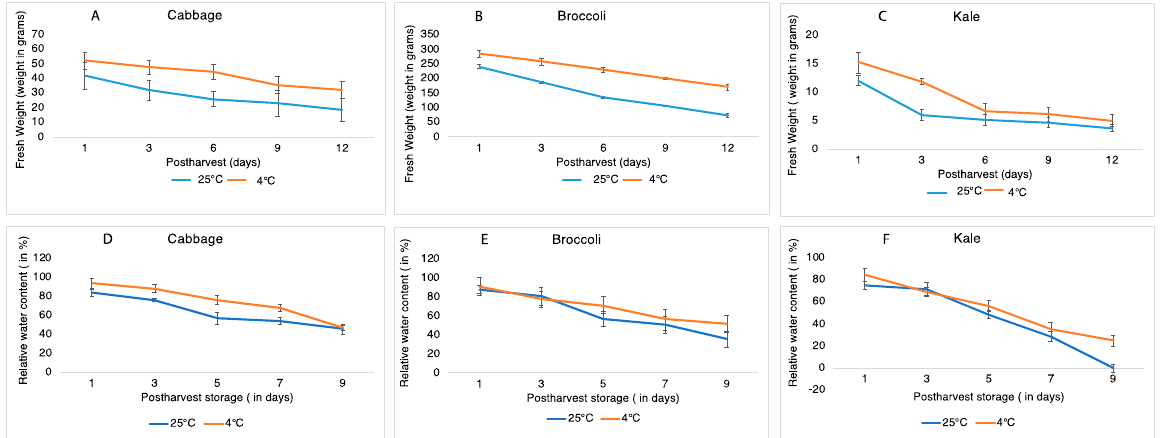
Figure 2. Fresh weight and relative water content in cabbage leaves, broccoli florets and kale leaves stored at 25 °C (blue) and 4 °C (red) in 12 days. ( A–C ) showing fresh weight (in %); ( D–F ) relative water content in three vegetables. Data represents means ± SE bars (n = 4) for each day). Asterisks (*, if any) indicate statistically significant differences between day 1 (control) and stored sample under the same storage temperature ( p < 0.05).